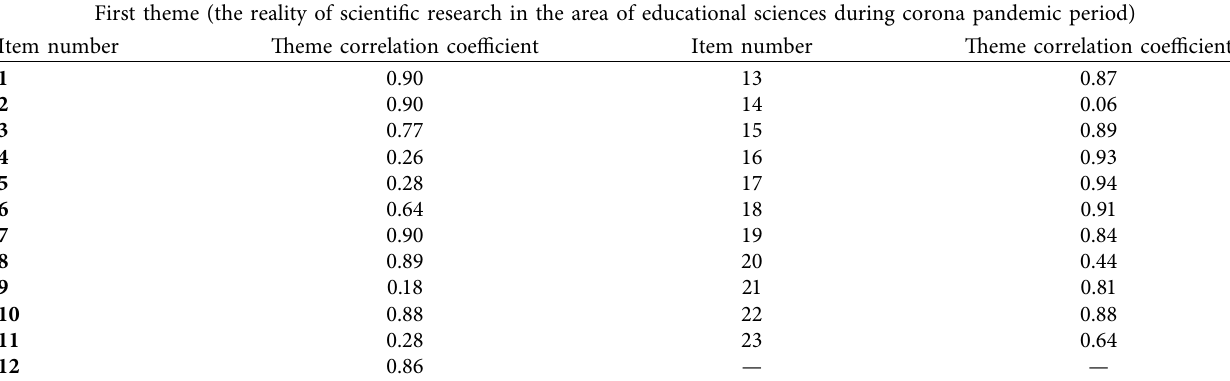
Table 3: Pearson correlation coefficients for the items of first theme with total degree of the theme.